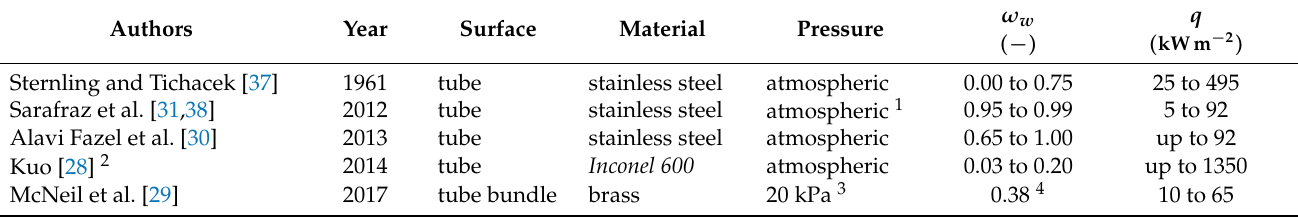
Table 4. Experimental measurements of HTC during pool boiling of water–glycerin mixtures reported in the literature.